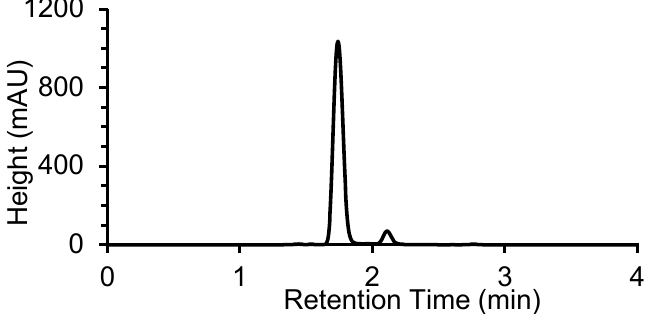
Figure 2. The HPLC spectrum of β-asarone (1.7 min; >95% purity).